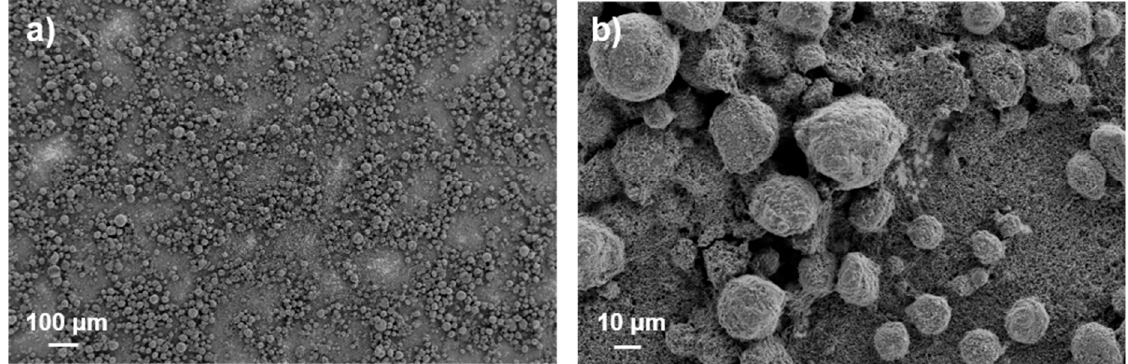
Figure 1. SEM images of the 5L anode microstructure obtained by printing ink at 25 wt% of dry content ( a ) ×150 and ( b ) ×1400. content ( a ) × 150 and ( b ) ×